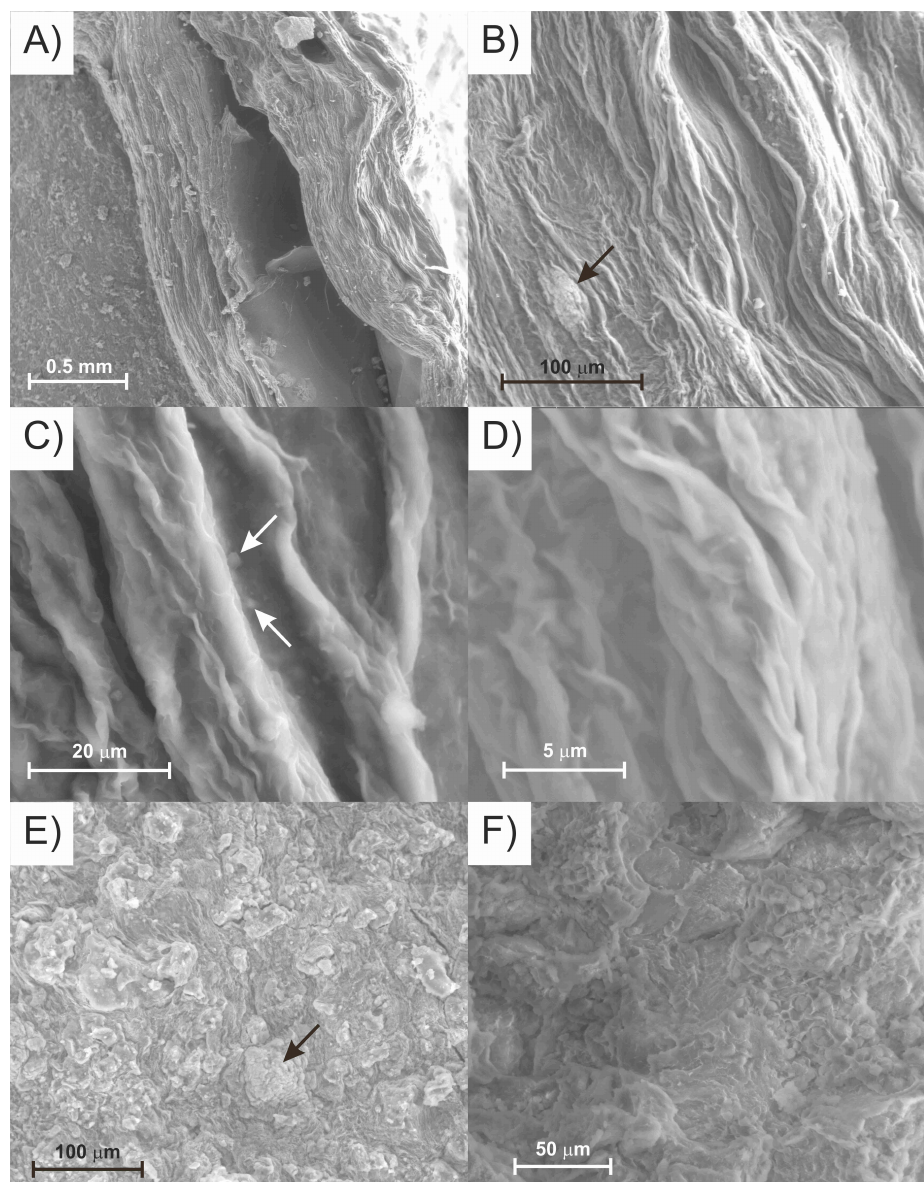
Figure 5. Secondary electron (SE) images of the bottom half of the post-test sample (slice 1 piece AA and slice 2 piece BB). ( A ) Finely-laminated smectitic gel layer resting on bentonite substrate in slice 1 piece AA. Parting of the lamination is visible in the gel layer. ( B ) “Wrinkled skin” texture caused by drying and shrinkage of the smectitic gel from slice 1 piece AA. A lenticular aggregate of microcrystalline gypsum (arrowed) can be seen to nucleate within the gel. ( C ) SE image of the smectitic gel layer (slice 1 piece AA), showing higher-resolution detail of the “wrinkled skin” texture. Tiny microcrystals of gypsum (arrowed) can be seen within the gel (slice 1 piece AA). ( D ) Higher magnification SE image of the extremely fine and uniform nature of the gel on slice 1 piece AA, within which no discrete clay particles can be resolved under the SEM. ( E ) SE image illustrating the relatively coarse, granular fabric of the bentonite substrate immediately beneath the gel layer (slice 1 piece AA). Subrounded, partially-hydrated bentonite aggregate grains within a fine, smectite-rich clay matrix are clearly discernable. A discrete grain of gypsum (arrowed) is also shown. Fine, sigmoidal grain boundary microfractures are evident. ( F ) Typical compacted bentonite fabric from slice 2 piece BB, showing close-packed bentonite aggregate grains within tight clay